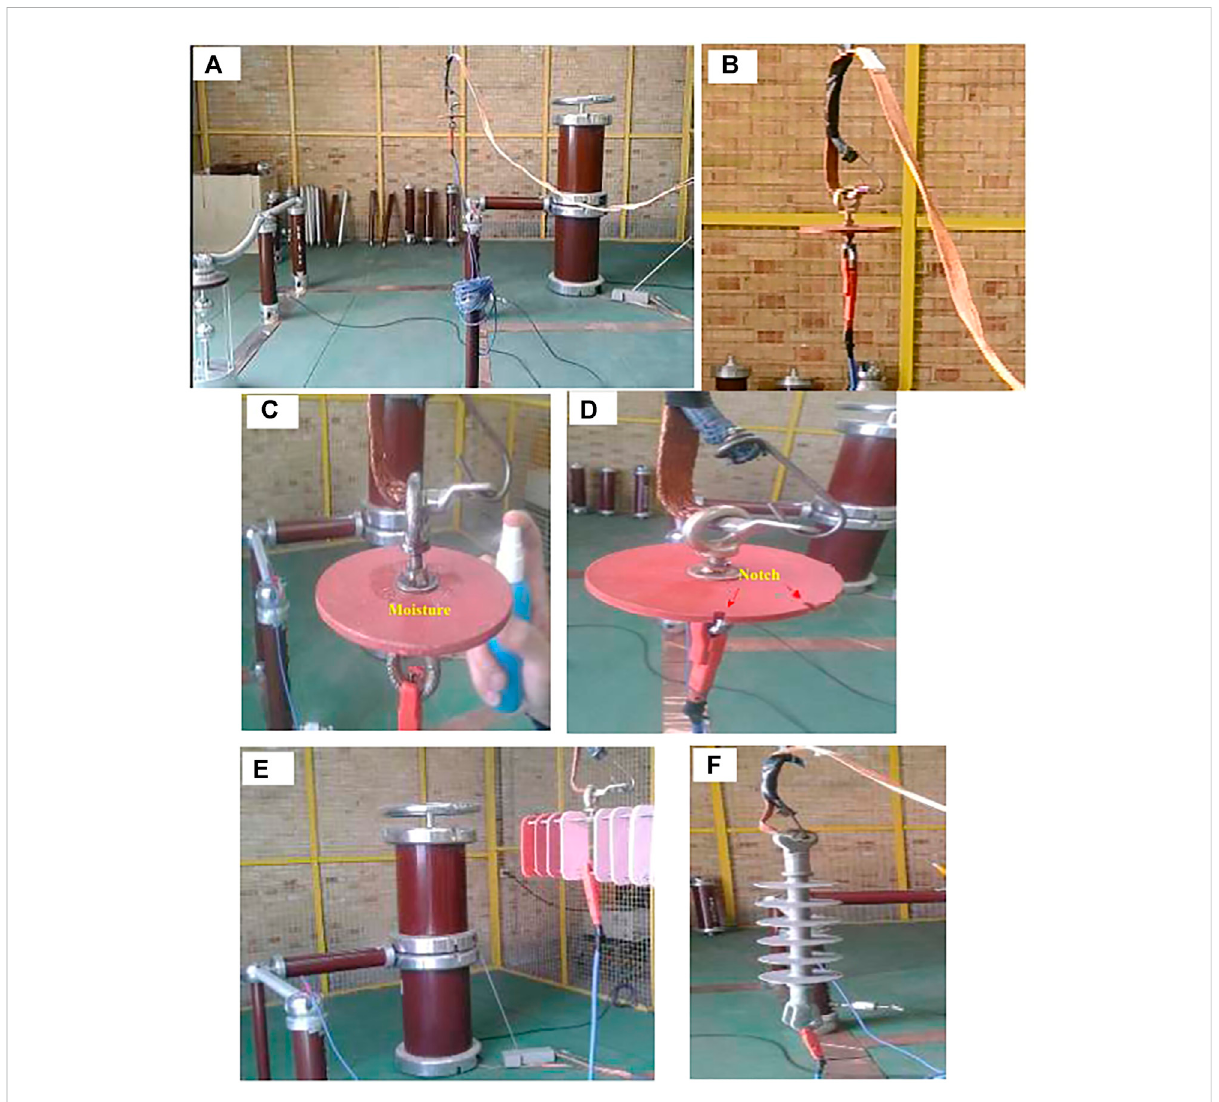
FIGURE 2 Setup of the high-power voltage tests for sheds in (A) maximum stability, (B) dry max endurance, and (C) wet max endurance voltage tests, as well as (D) the notched max endurance voltage and (E) erosion-resistance test. (F) High-power voltage tests for a real high-voltage insulator containing a shed and